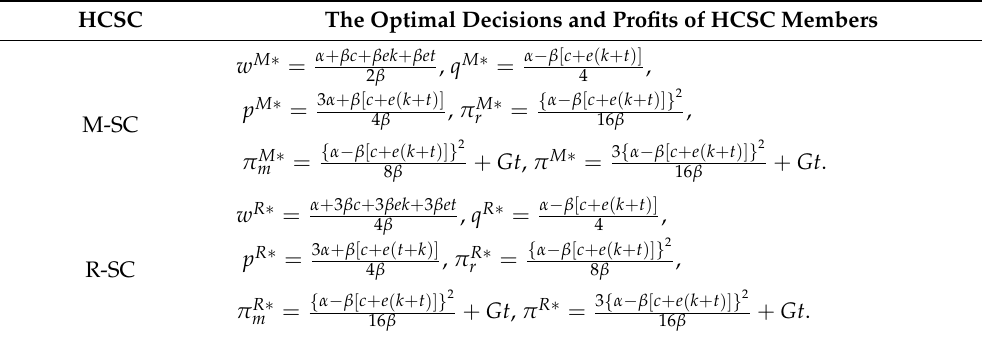
Table 1. Optimal decisions and profits of different